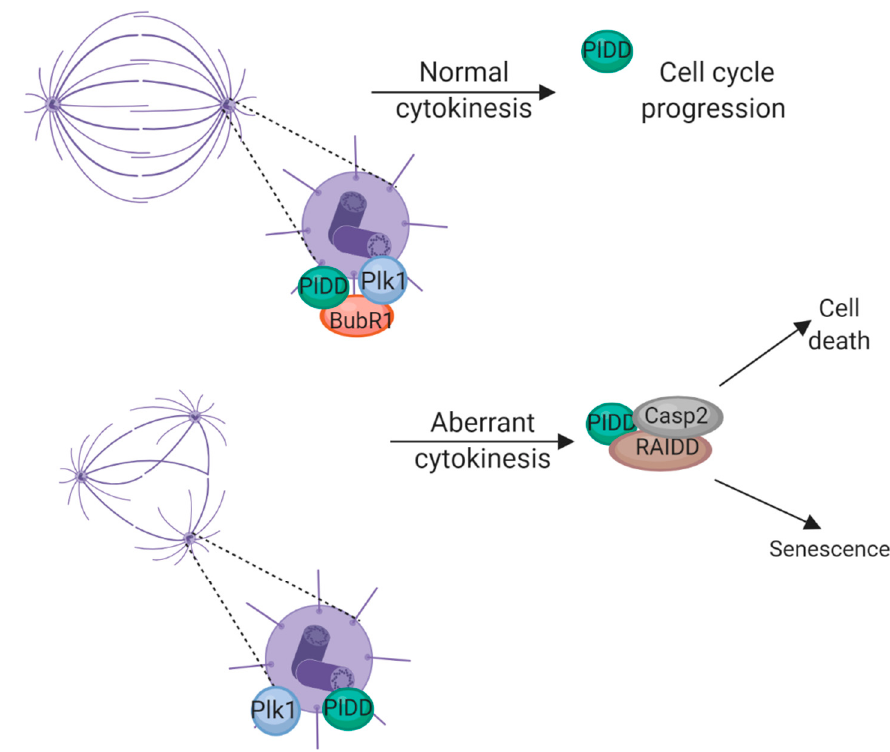
Figure 3. Interaction of BubR1 and PIDD at centrosomes. In the incidence of supernumerary centrosomes, PIDD interacts with RAIDD and assembles to PIDDosome resulting in either cell death or senescence depending on p53 status. Image created using BioRender.